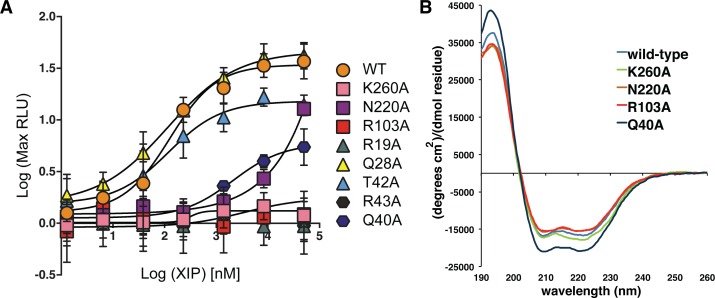
Luciferase reporter assay results of ComR S. suis mutants stimulated with Suis C7 XIP.
(A) Point-mutations were introduced into ComR S. suis in the DBD (triangles R19A, Q28A, T42A), the DBD-TPR interface (hexagons Q40A, R43A), or in the conserved (K260A, R103A) or variable surfaces (N220A) of the XIP binding pocket (square symbols). Wild-type S. suis ComR activity with Suis C7 XIP is depicted as circles. (B) Circular dichroism spectra of purified variant proteins of interest displaying decreased transcriptional activity compared to wild-type, plotted as mean residue ellipticity.